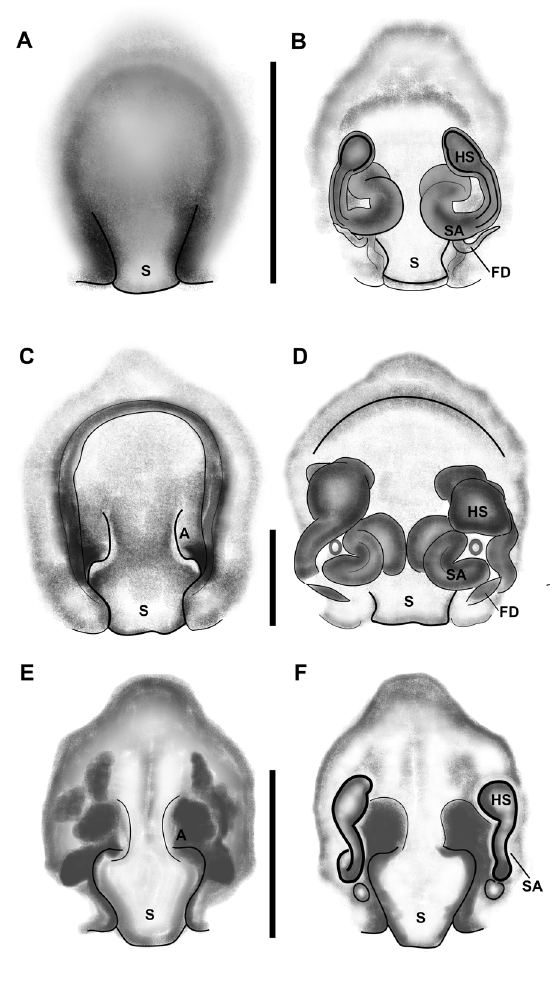
Fig. 11. Lycosa female epigyne, line drawings . A–B . Lycosa sp. (HUJ INV-AR20573). A . Ventral view. B . Dorsal view. C–D . Lycosa hyraculus sp. nov., paratype (HUJ INV-AR20817). C . Ventral view. D . Dorsal view. E–F . Lycosa piochardi Simon, 1876 (HUJ INV-AR20709). E . Ventral view. F . Dorsal view . Scale bars = 0.5 mm. Drawings by I. Armiach